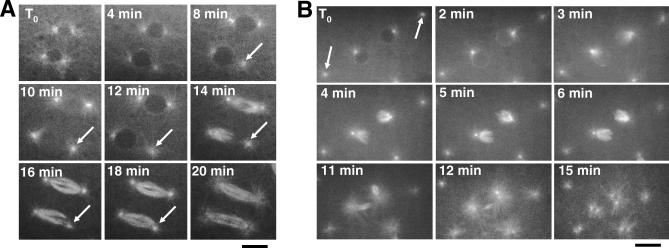
Centrosome Dissociation Is Observed in Prophase in polo-Scant-Derived EmbryosTime-lapse fluorescence microscopy of embryos derived from GFP-β-tubulin; polo11 Scant/+ + mothers. In both (A) and (B), centrosomes dissociate prior to nuclear envelope breakdown.(A) In some cases, the disassociated centrosome (arrow) can be recaptured and mitosis can proceed normally.(B) In other cases, centrosomes are lost irreversibly and gross mitotic defects develop. Both series (A and B) were taken from Video S2. Scale bars correspond to 10 μm.